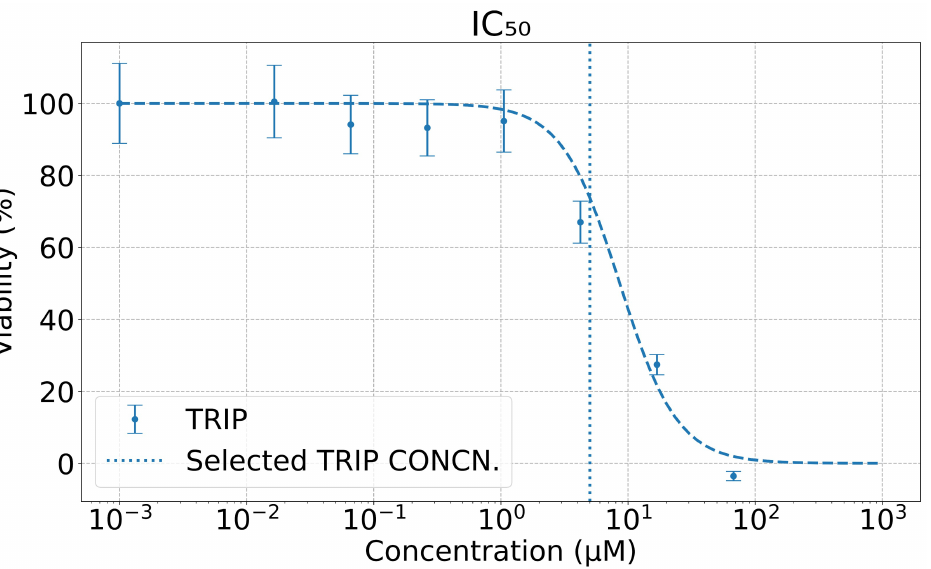
Figure 2. The dose-response curves of TRIP (blue line). The half maximal inhibitory concentrations TRIP = 5.0 µ M (vertical = 10.8 ± 2.8 µ M. A below-IC (IC 50 ) of the drug is IC TRIP 50 concentration, C 50 blue line), was used in all MEIRS